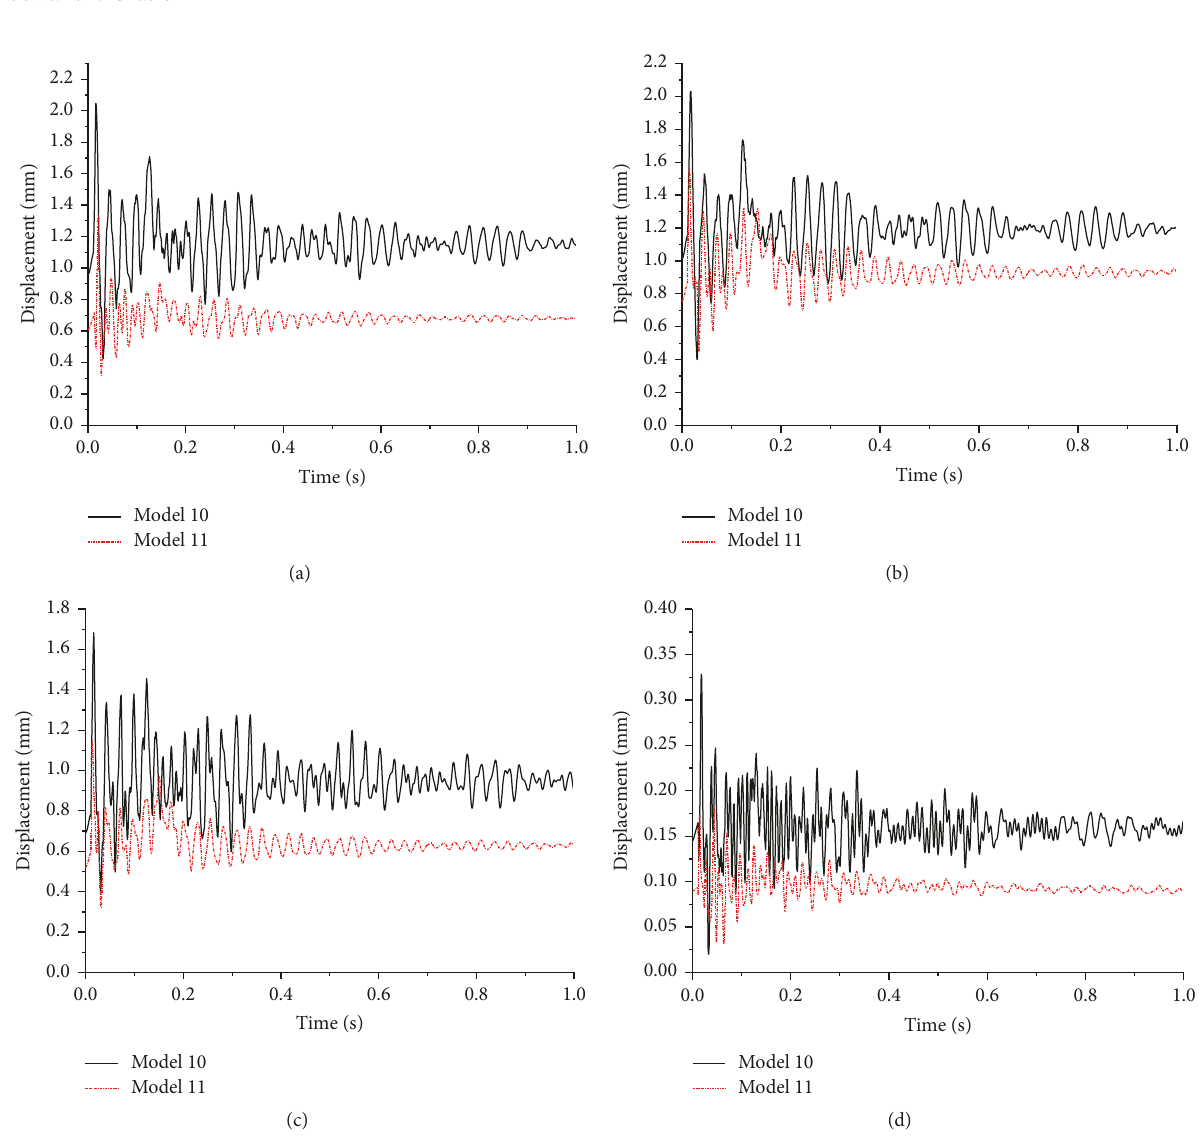
Figure 23: Node displacement-time curve: (a) node 1, (b) node 2, (c) node 3, and (d) node 4.